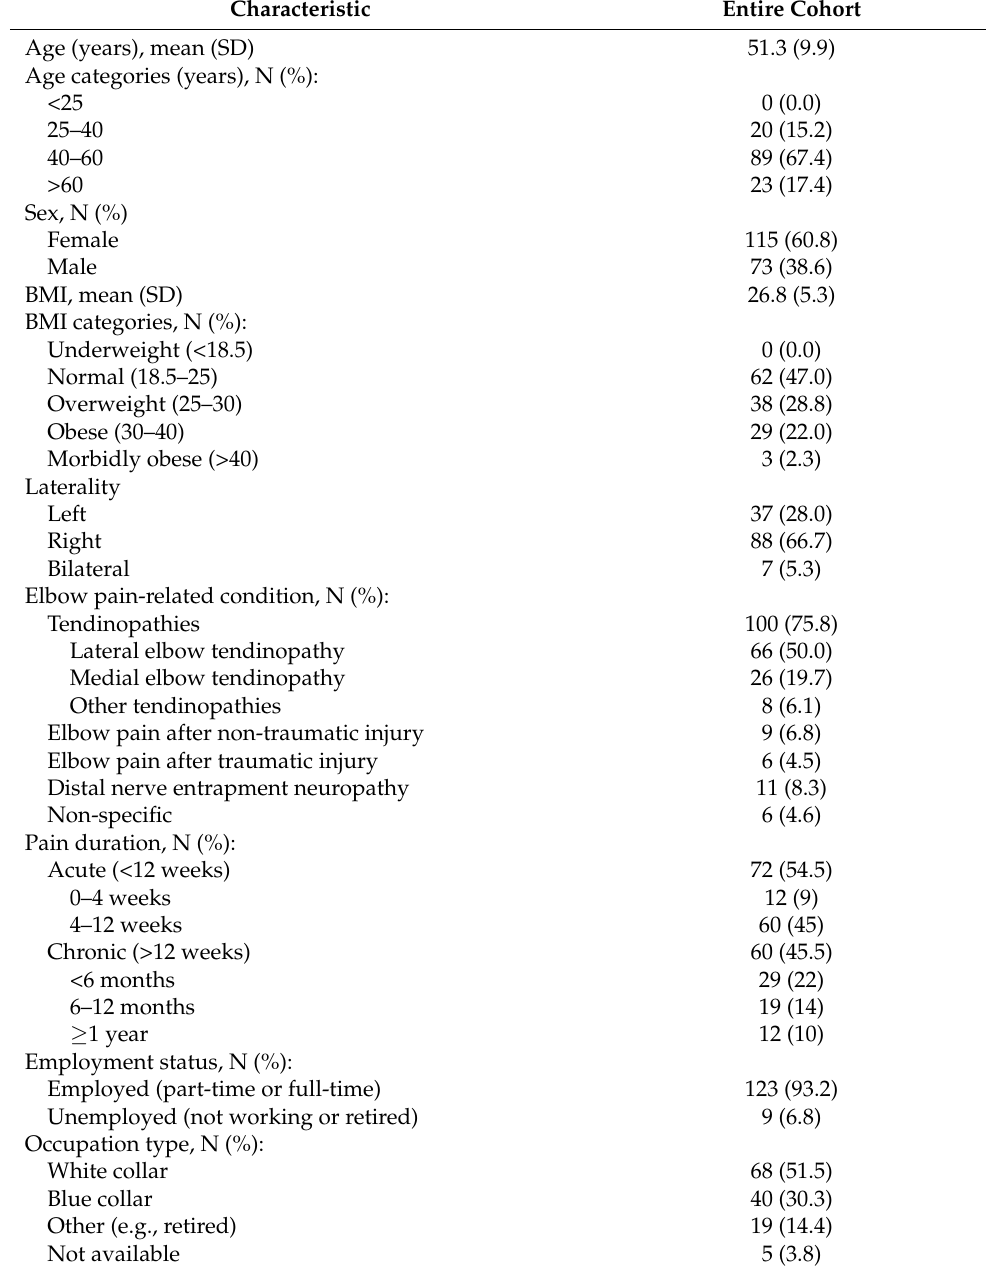
Table 1. Baseline characteristics of study participants (N =